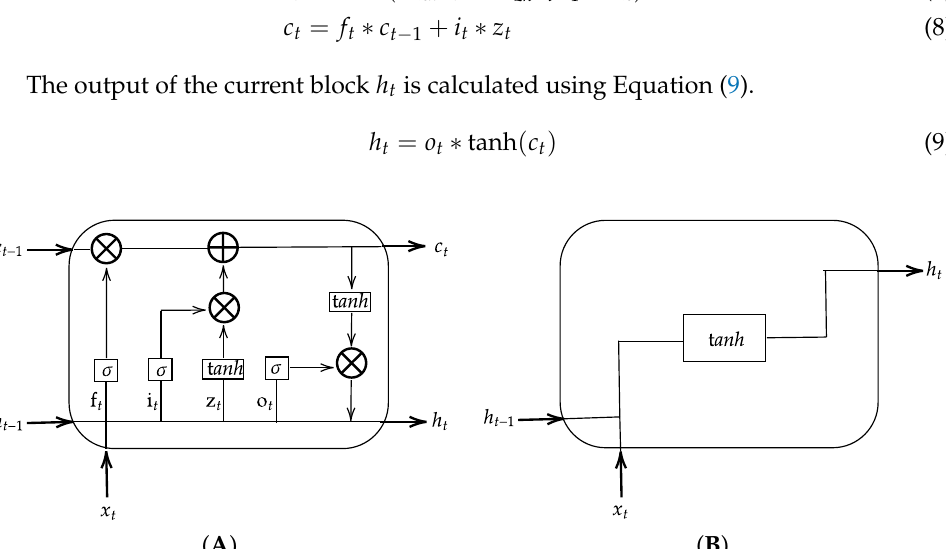
Figure 4. ( A ). Diagram of LSTM unit and ( B ). regular RNN unit. Left side shows LSTM cell, right side shows RNN cell.